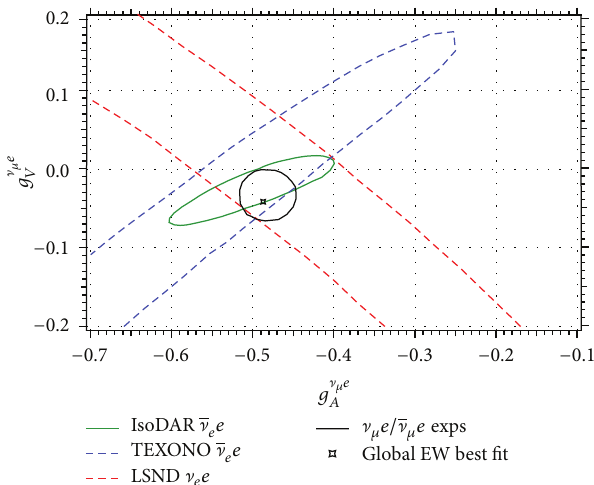
Figure 9: IsoDAR’s sensitivity to 𝑔 𝑉 and 𝑔 𝐴 along with allowed regions from other neutrino scattering experiments and the elec- troweak global best fit point taken from [16]. The IsoDAR, LSND, and TEXONO contours are all at 1𝜎 and are all plotted in terms ] 𝜇 𝑒 = 𝑔 ] 𝑒 𝑒 − 1 to compare with ] of 𝑔 𝑉,𝐴 𝑉,𝐴 contour is at 90%